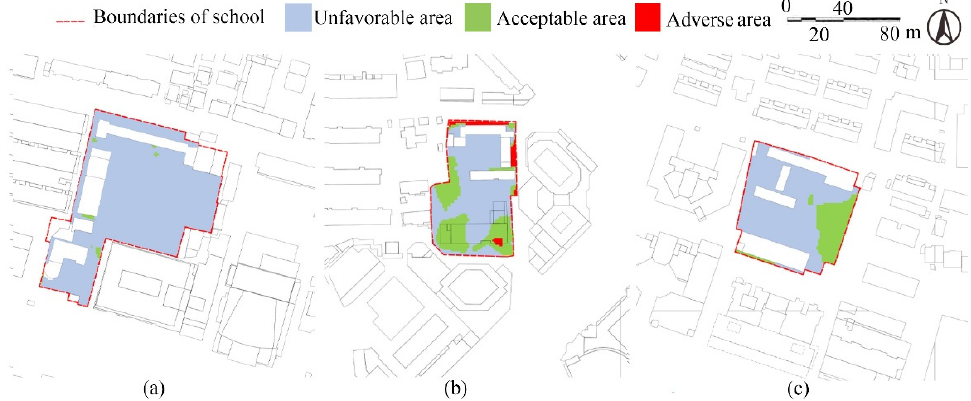
Figure 12. Distribution of wind comfort zones at the pedestrian level in three primary schools in winter in the 2010s: ( a ) Changjiang Road Primary School; ( b ) Chibi Road Primary School (Shanxi Road Campus); ( c ) Jianye Road Primary School.